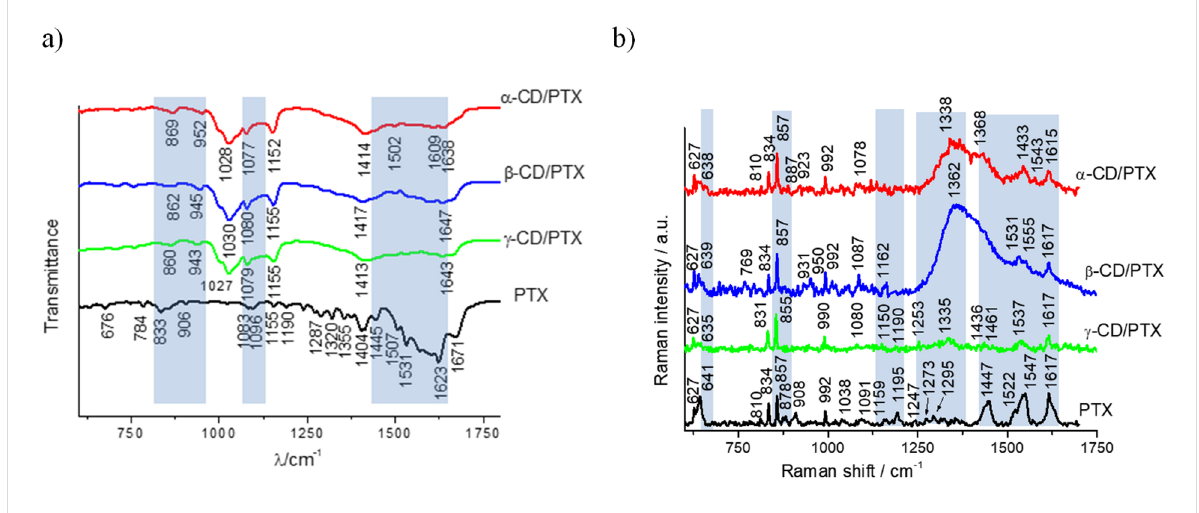
Figure 6: a) FTIR–ATR and b) Raman spectra of PTX together with its complexes with α -CD, β -CD and γ -CD.